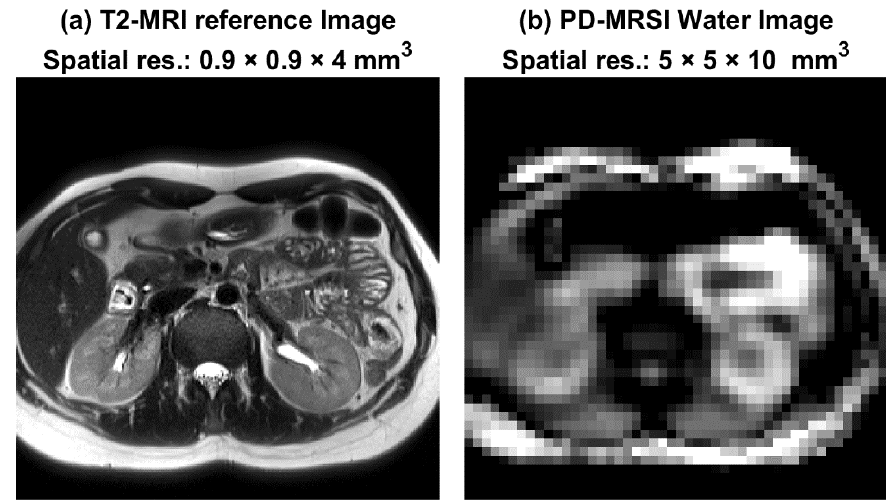
Figure 3. Example of anatomical image outputs. ( a ) A T2-MRI anatomical image (0.9 × 0.9 × 4 mm 3 ); ( b ) The PD-water-only-MRSI anatomical image (5 × 5 × 10 mm 3 ) for the same subject. Although spatial resolution and contrast are different (due to the variation in sequence parameters), similar structural details of the anatomy were demonstrated by both sequences.